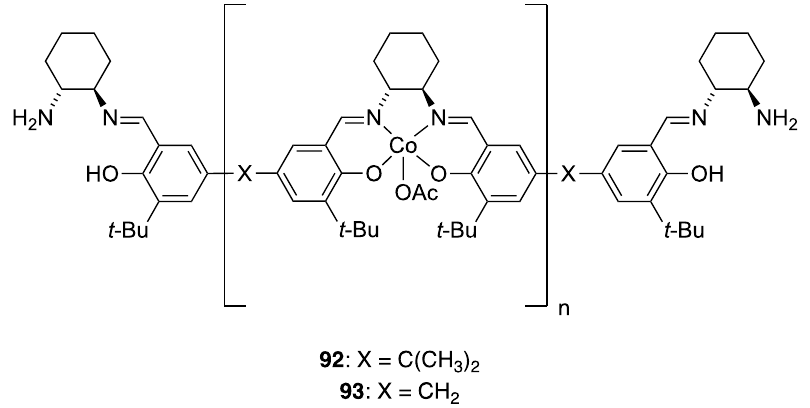
Figure 37. Linear polymeric Co–salen catalysts 92 and 93 .